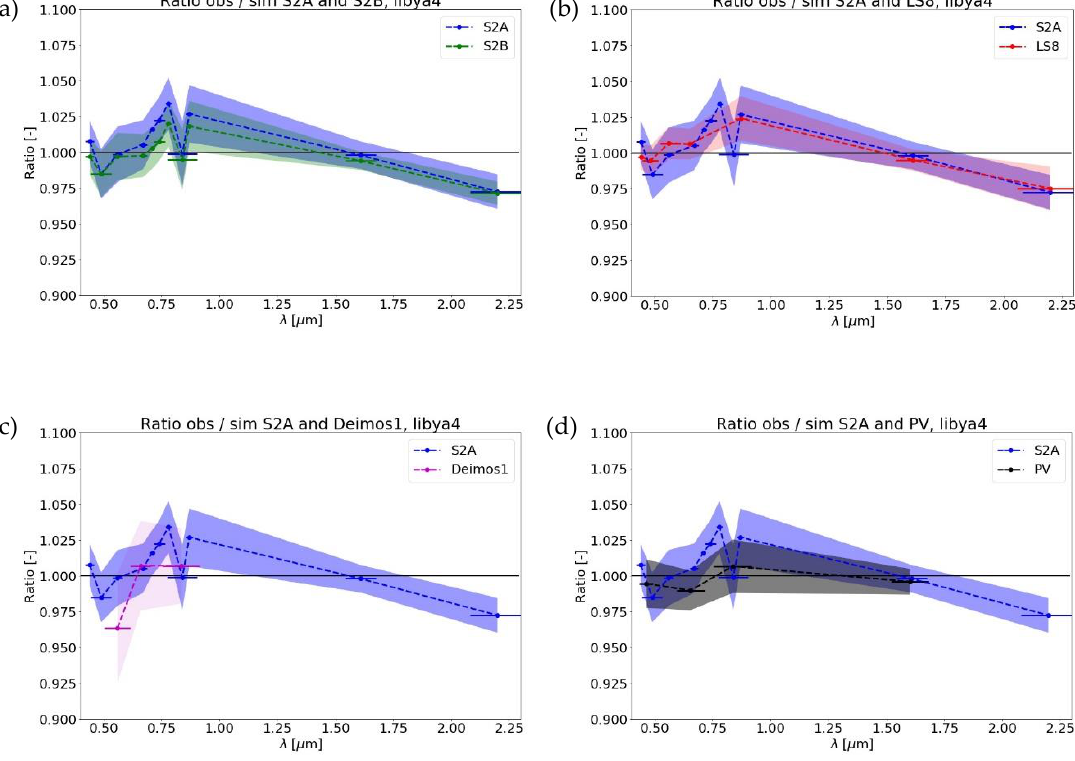
Figure 2. Mean ratio (over all observations) of the satellite-measured top-of-atmosphere (TOA) reflectances to the 6SV TOA reflectance simulations over Libya-4: ( a ) Sentinel-2A versus Sentinel-2B, ( b ) Sentinel-2A versus Landsat 8, ( c ) Sentinel 2A versus Deimos-1,and ( d ) Sentinel-2A versus PROBA-V. The shaded areas denote the ± 1 standard deviation ( σ ) of the obtained ratios. The horizontal bars indicate the spectral band widths of the respective sensors. Table 3. Mean ratio (over all observations) of the satellite-measured TOA reflectances to the 6SV TOA reflectance reference simulations over Libya-4.